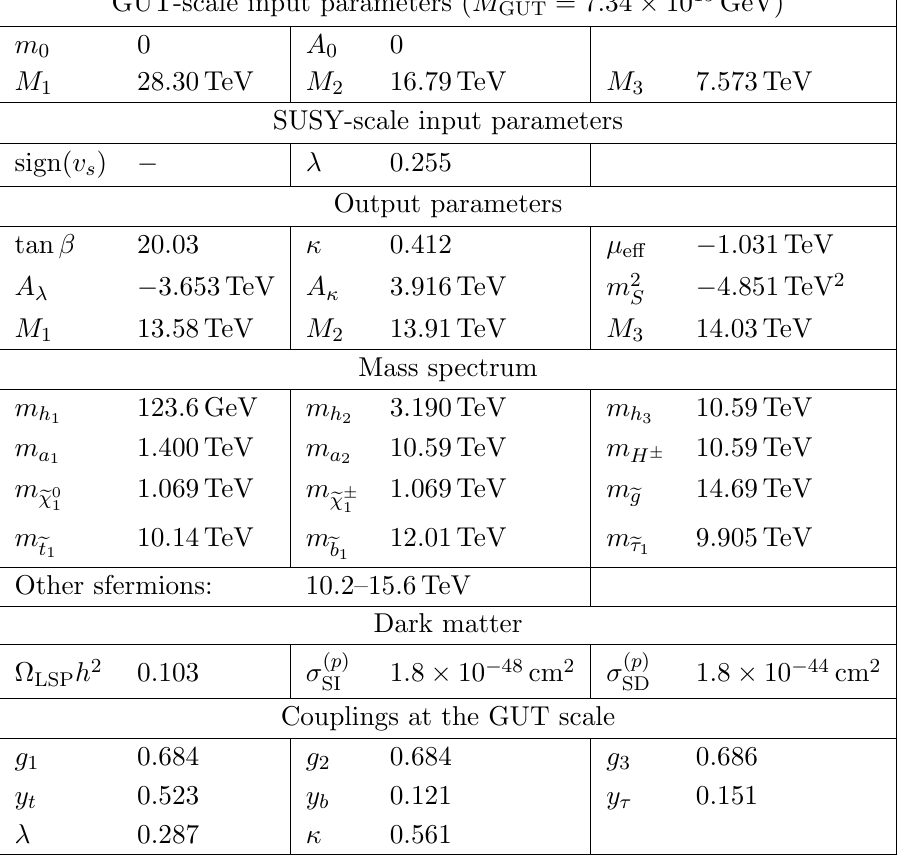
Table 2. Typical mass spectrum of the NMSSM with non-universal gaugino masses and the no-scale